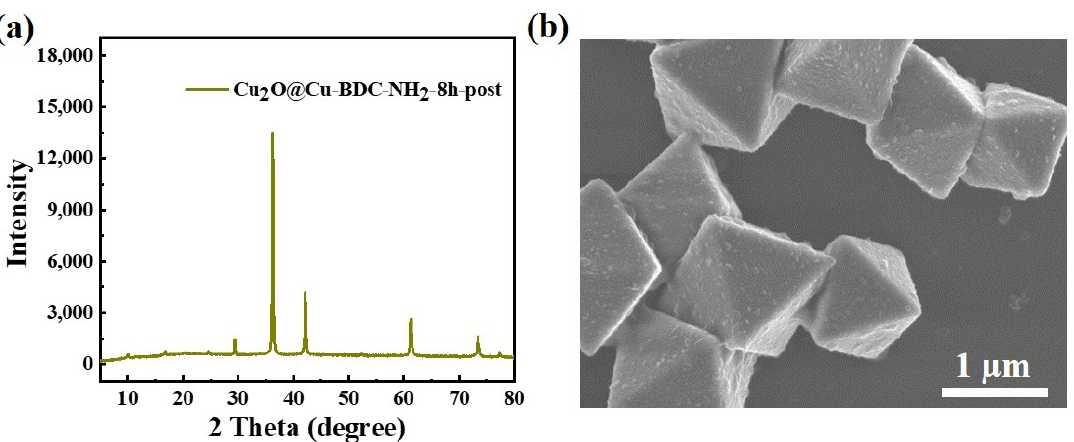
Figure 6. ( a ) XRD patterns and ( b ) SEM image of Cu 2 O@Cu-BDC-NH 2 -8h after the catalytic